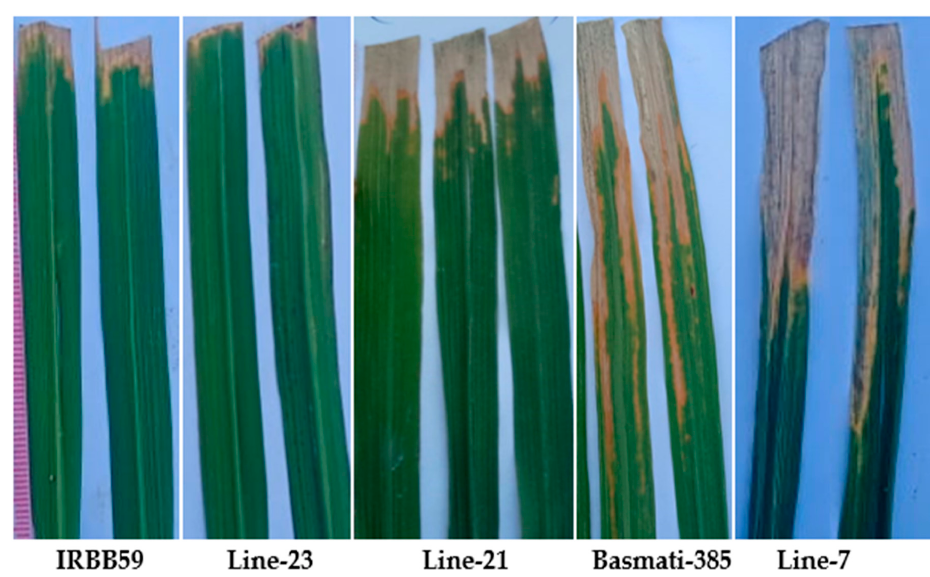
Figure 7. Lesion developed by Xoo isolates on advanced RILs of rice.